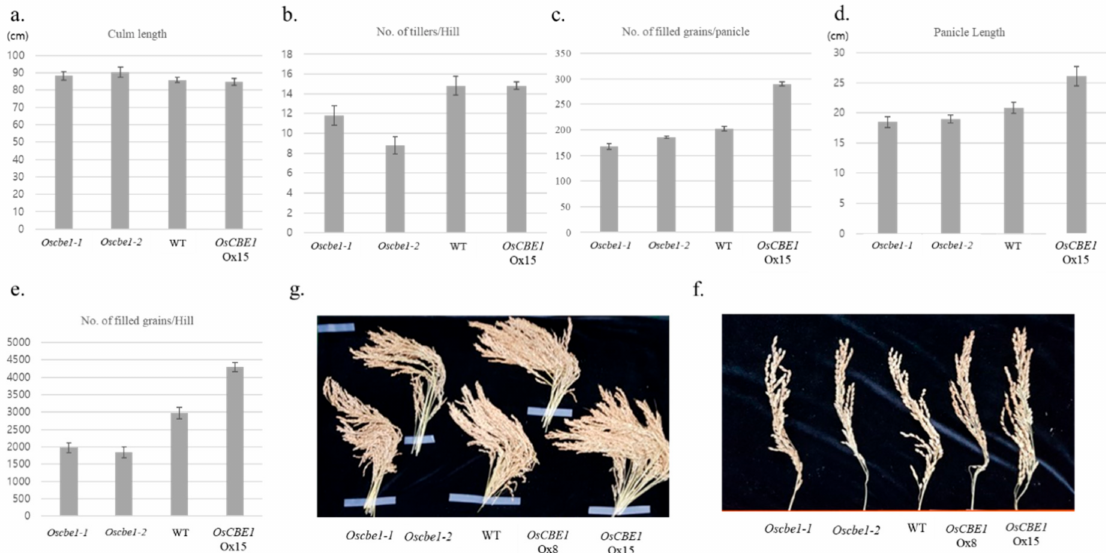
Figure 3. Agronomical traits of CBE1 lines. ( a – e ) Agronomical traits of OsCBE1 lines are presented. ( a ) Culm length; ( b ) Number of tillers per hill; ( c ) Number of filled grains per panicle; ( d ) Panicle Length; ( e ) Number of filled grains per hill. Each of the results are presented as means ± standard error. ( f ) Panicles from a single OsCBE1 line plant are presented. ( g ) Single panicle of each OsCBE1 line are